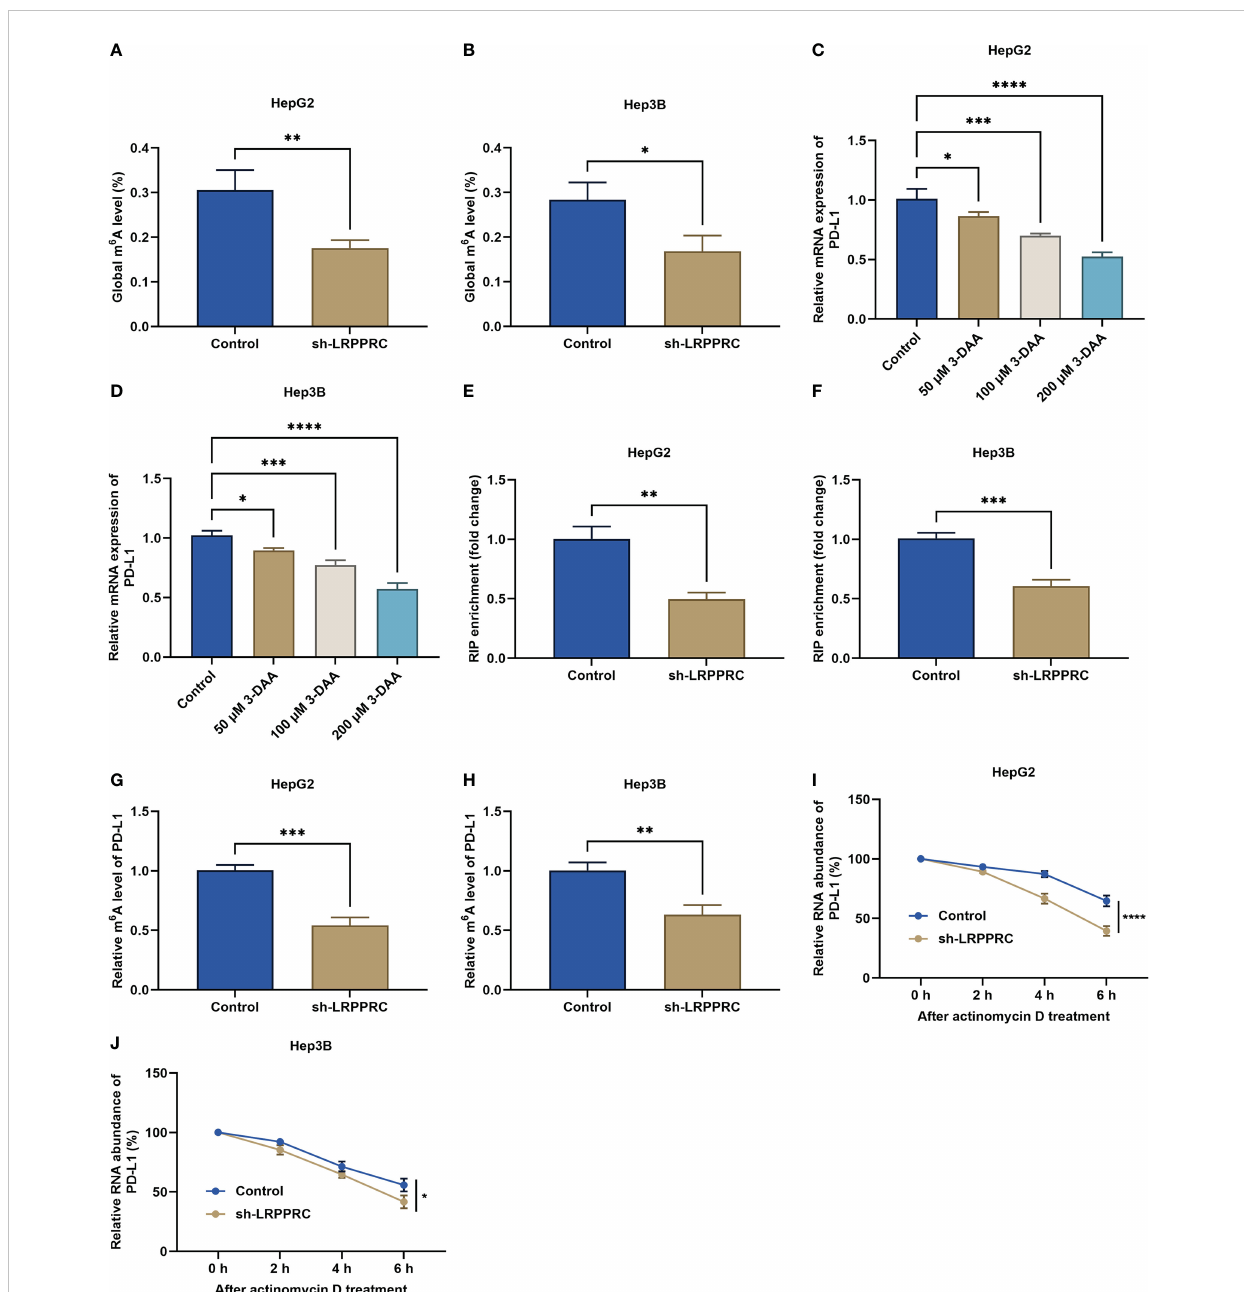
FIGURE 5 Leucine rich pentatricopeptide repeat containing (LRPPRC) elevates m 6 A modi fi cation of PD-L1 mRNA in hepatocellular carcinoma (HCC) cells. (A , B) the overall m 6 A modi fi cation in HepG2 and Hep3B cells with LRPPRC de fi ciency. (C , D) PD-L1 transcript level in LRPPRC-knockout HCC cells following 3-DAA exposure. (E , F) RIP-qPCR for the evaluation of the interactions of LRPPRC with PD-L1 mRNA in HCC cells with LRPPRC de fi ciency. (G , H) The relative m 6 A level in PD-L1 mRNA in LRPPRC-knockout HCC cells. (I , J) PD-L1 transcript level in LRPPRC-de fi cient HCC cells following actinomycin D administration. * p < 0.05; ** p < 0.01; *** p < 0.001; **** p <